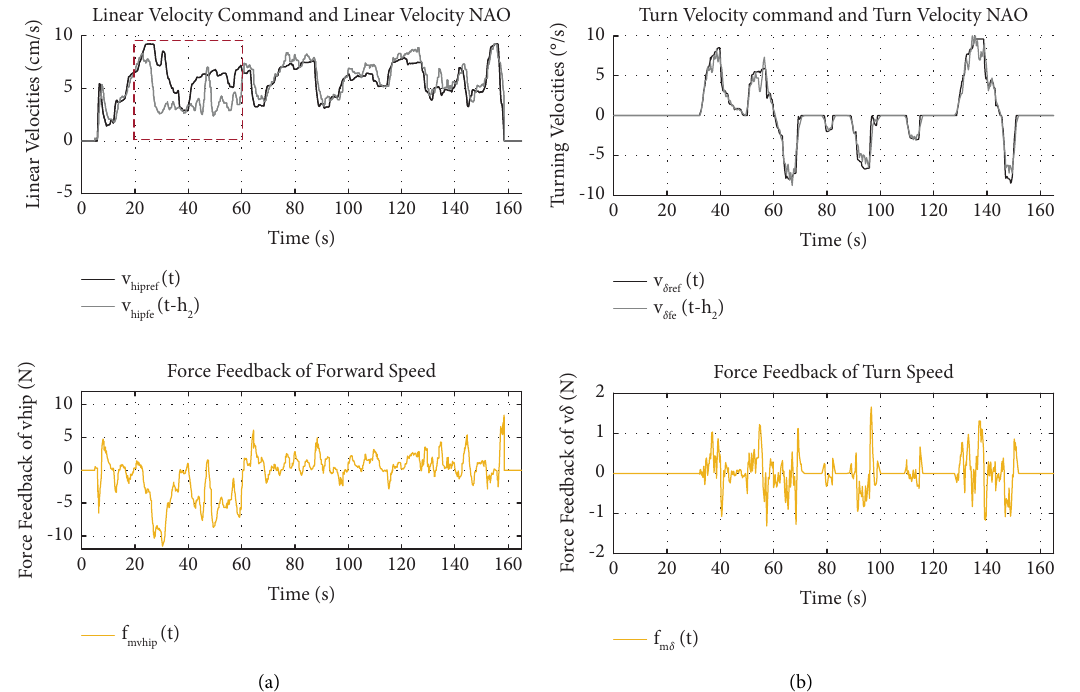
Figure 11: Coordination error of the forward and turn speed and force feedback: (a) linear velocity command and linear velocity NAO and (b) turn velocity command and turn velocity NAO.